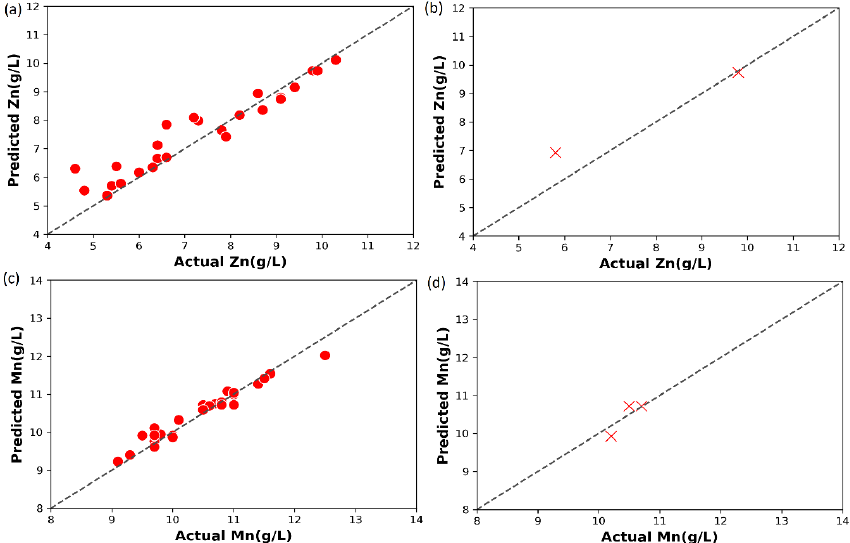
Figure 7. Actual versus random forest regression-based predicted ( a ) Zn (g/L) training, ( b ) Zn (g/L) testing, ( c ) Mn (g/L) training and ( d ) Mn (g/L) testing data.